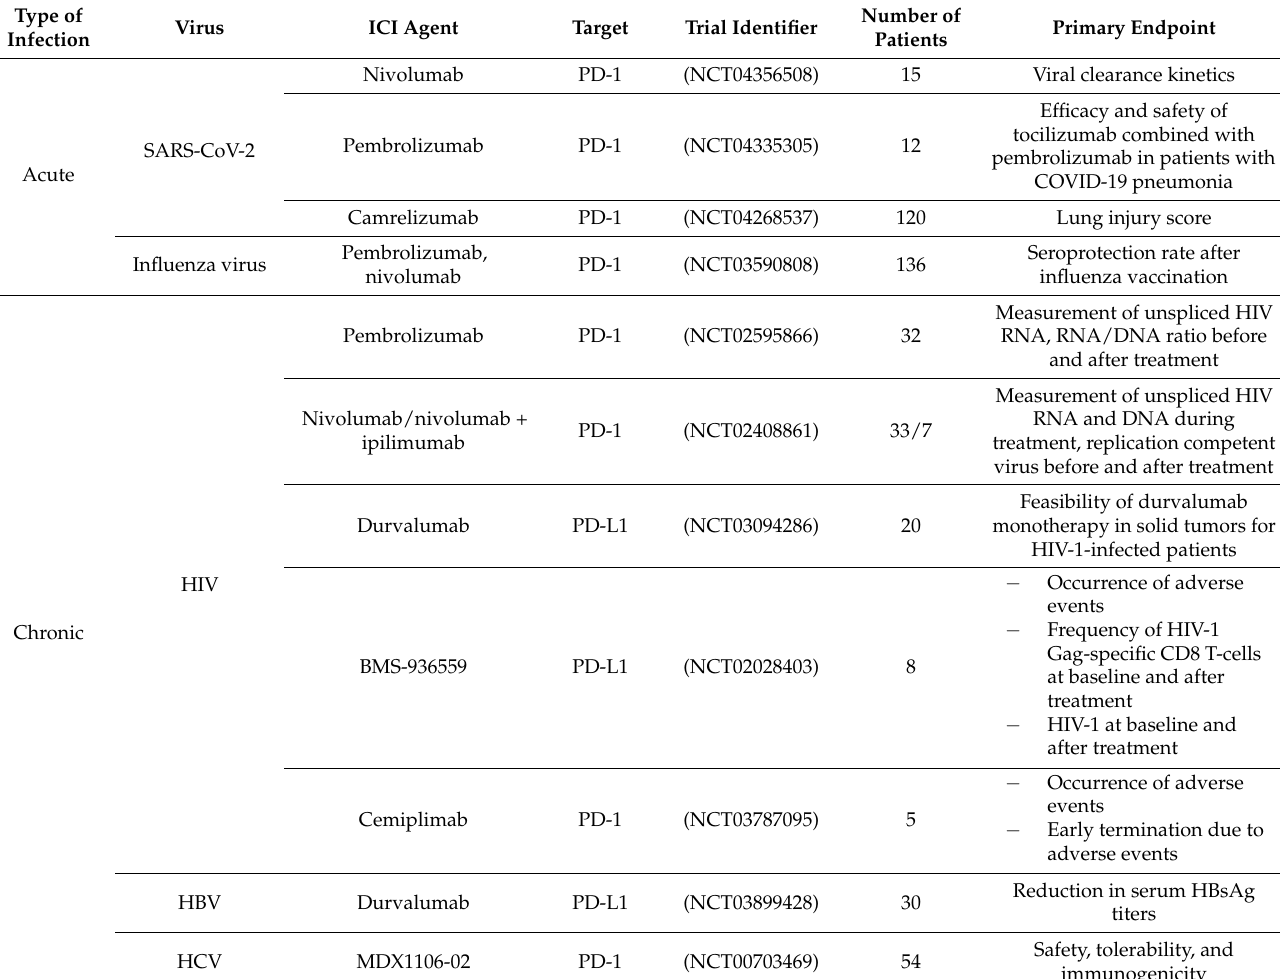
Table 1. Anti-PD-1/PD-L1 agents used in viral infections clinical